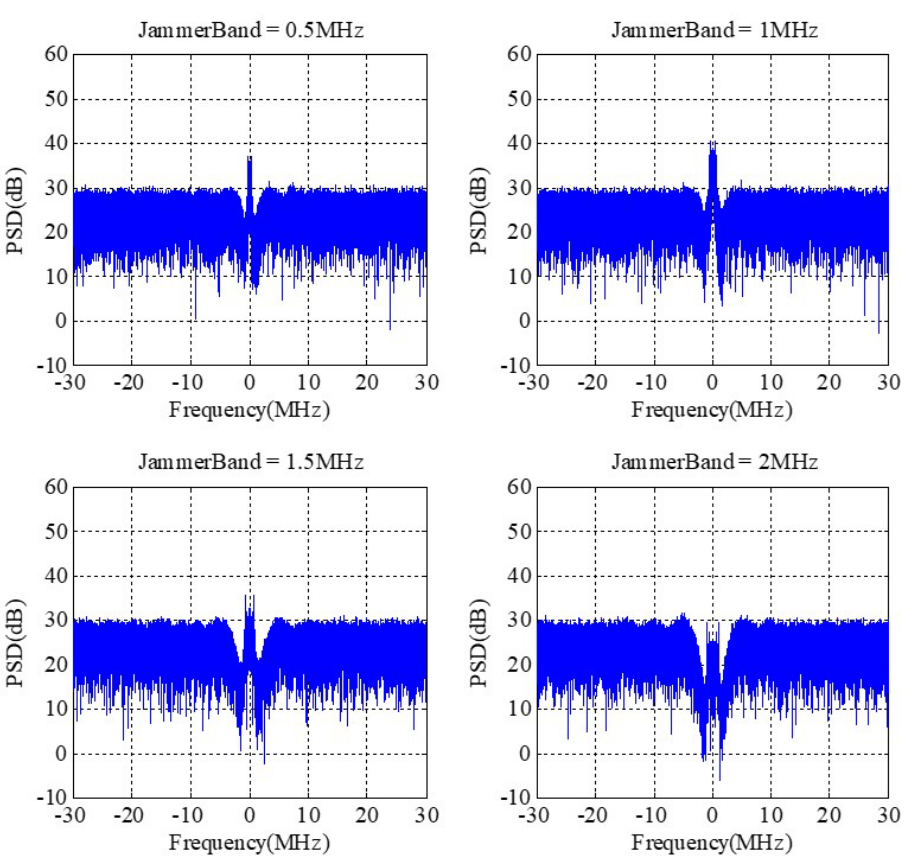
Figure 15. Spectral characteristics after anti-jamming in difference interference bandwidths.